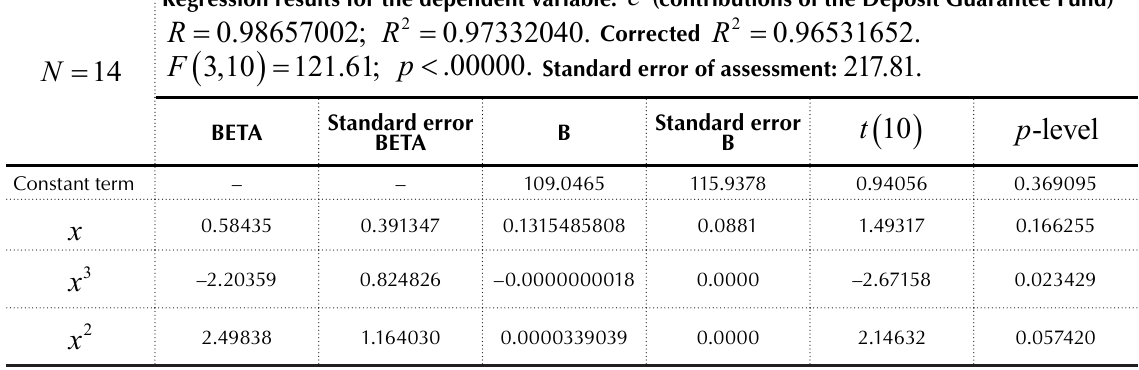
Fund ( ) c from the volume of the fund ( ) x of the law of distribution of excesses to the normal law is shown in Figure 2. Table 3. The results of regression of contributions from the members of the Deposit Guarantee Fund ( ) c from its volume ( ) x Regression results for the dependent variable: c (contributions of the Deposit Guarantee Fund) 0.98657002; R = 2 0.97332040. R = Corrected .00000. p < Standard error of assessment: 217.81. 14 N = Standard error BETA BETA